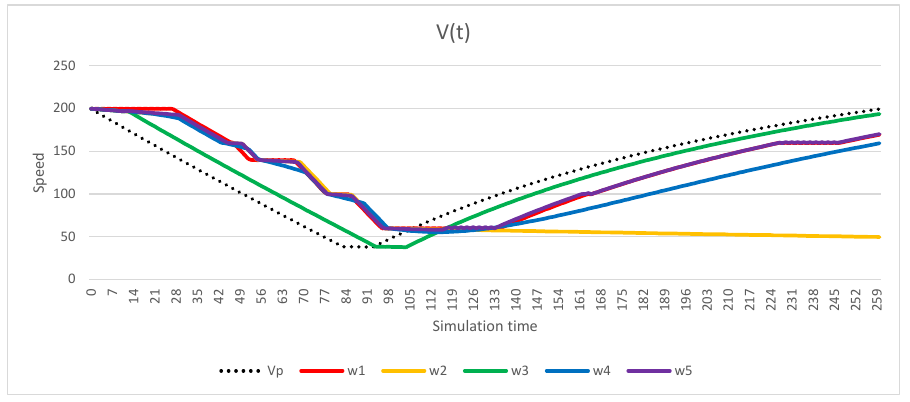
Figure 17. Velocity change V ( t ) in simulation by context 3 for distance D 0 = 2000 m.